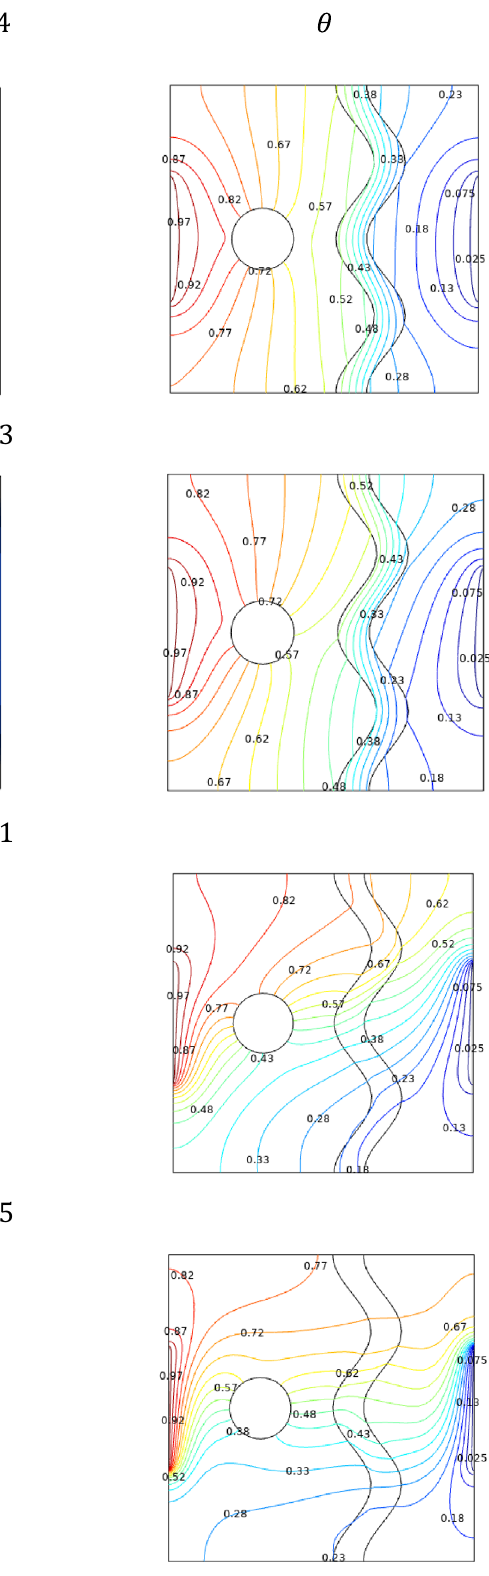
Figure 4. Variations of the streamlines (left), isotherms (right) with various Rayleigh number ( Ra ) at, Ha 0.01 , φ 0.2 and ω 0 0.02 , ε 2 , Da N = = = = =